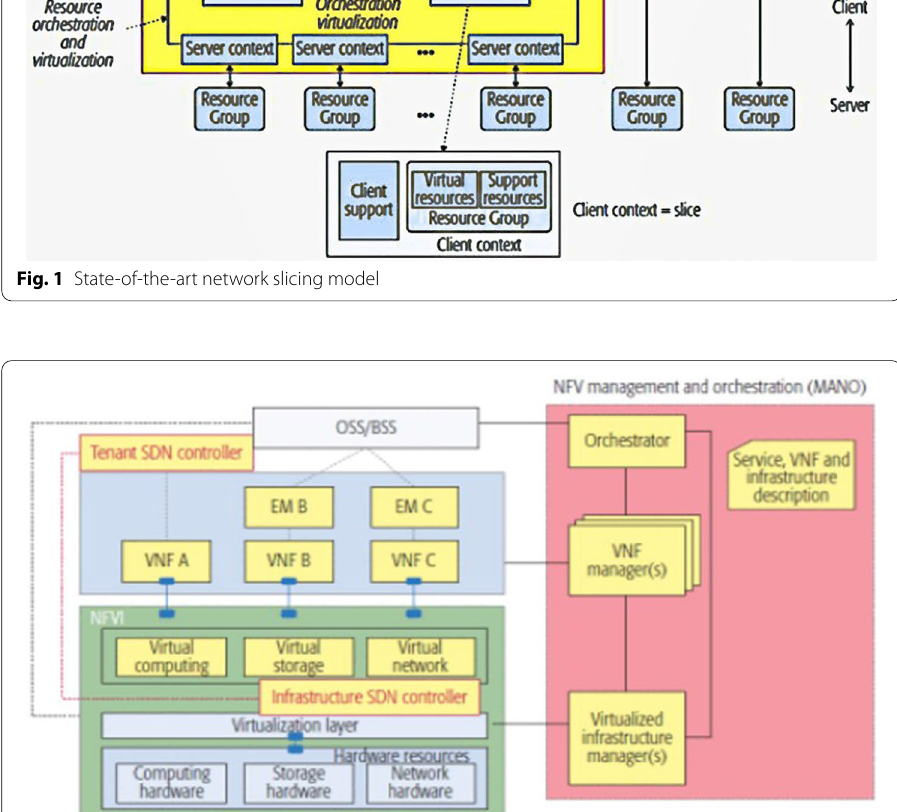
Fig. 2 SDN and NFV integration